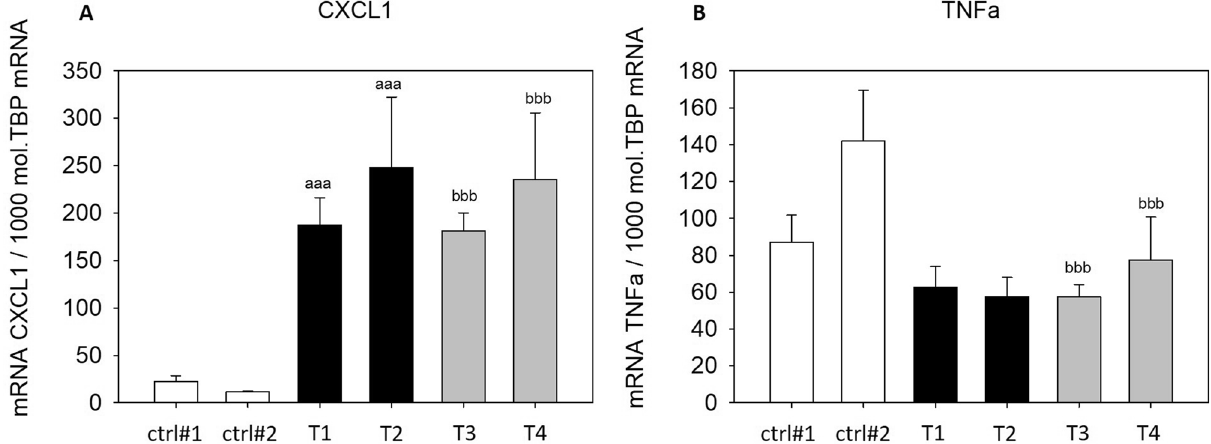
Figure 8. mRNA expression of CXCL1 ( A ) and TNFα ( B ) in THP-1 cells incubated with SGBS-CM. THP-1 cells were incubated for 4 days with SGBS-CM from d4 (T1 or T2) and d8 (T3 or T4) of adipogenesis. The corresponding controls were ctrl#1: RPMI + unconditioned induction medium from d4 (1:1) and ctrl#2: RPMI + unconditioned differentiation medium from d8 (1:1). For qRT-PCR, mRNA samples of THP-1 macrophages were taken at d7 of differentiation. The TATA-Box binding protein ( TBP ) was used as a housekeeping gene. The data were statistically analyzed by one-way ANOVA on ranks with the Student– Newman–Keuls method. N = 6, n = 1 (4 pooled wells); a p < 0.05, aa p < 0.01, aaa p < 0.001, THP-1 + SGBS-CM [d4] vs. ctrl#1 or ctrl#2; b p < 0.05, bb p < 0.01, bbb p < 0.001, THP-1 + SGBS-CM [d4] vs.